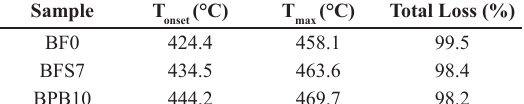
Table 5. Thermal properties of PEX’s samples.